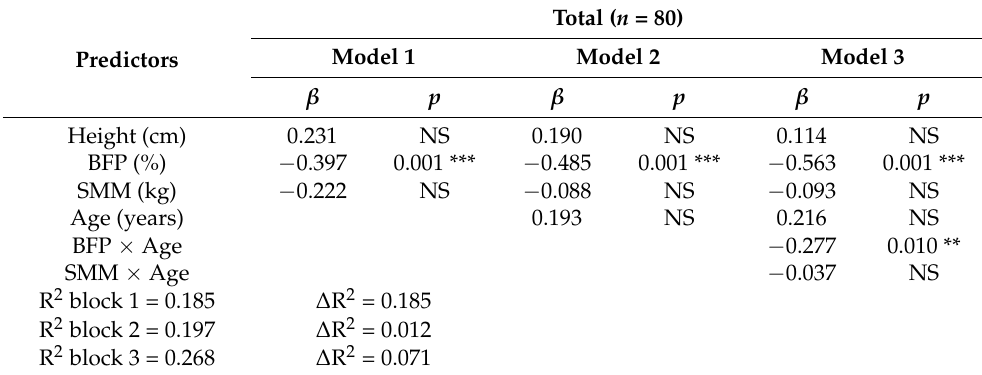
Table 2. Summary of the results of the hierarchical moderated regression analysis for predicting stride length mean (m).